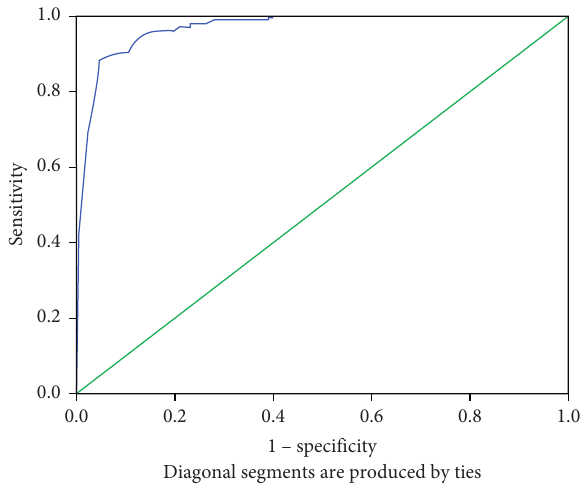
Figure 2: ROC curve of RUAC against standard MUAC. Table 6: Validity tests on RUAC measurements at WHO cutoff ( < 12.5cm) from Lanfro District, SNNPR, Southern Ethiopia, 2016 ( n �